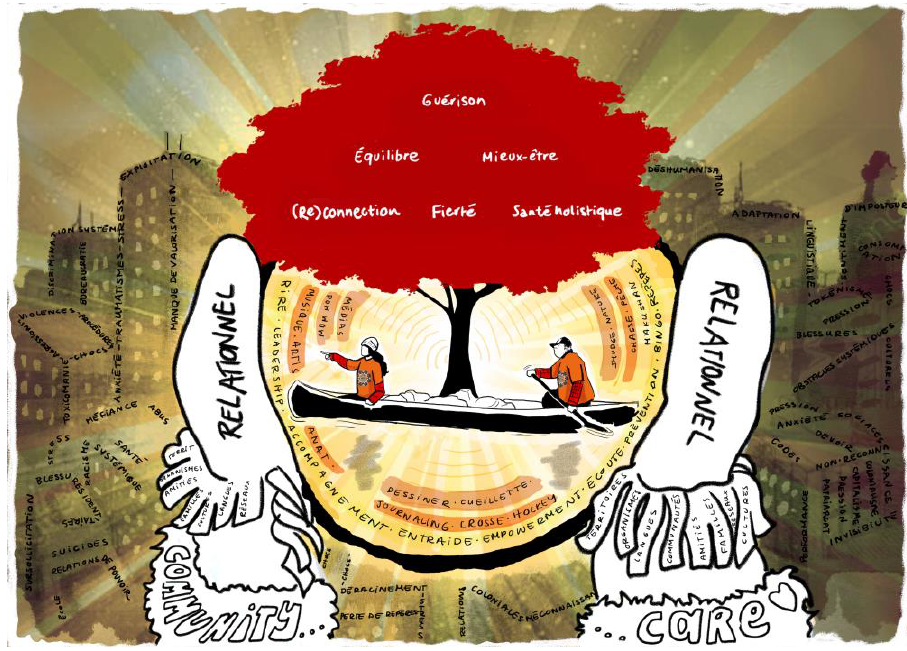
Figure 2. Postcard. Figure 2.